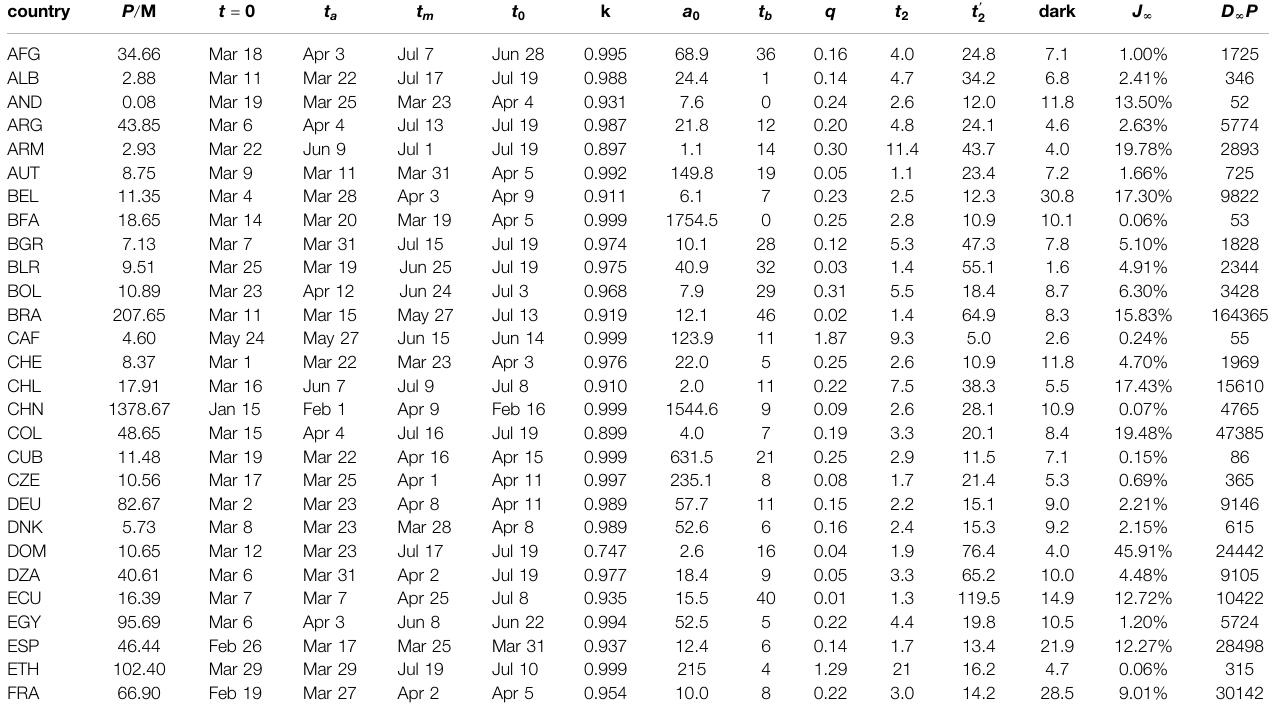
TABLE 2 | Model parameters and model implications. The columns are as follows: country ( α 3 code), population P in millions (M), outbreak time de fi ning t (cid:2) 0, fi tted time t a , estimated time t 0 corresponding to the reduced peak time τ 0 of j ( τ ) , fi tted SIR parameter k , fi tted initial infection rate a 0 , fi tted parameter t b , fi tted quarantine factor q , estimated doubling time t 2 characterizing the early exponential increase, estimated decay half life t ′ 2 characterizing the late exponential decrease, estimated unreported number of infections per reported number, estimated fi nal fraction J ∞ of infected population, fi nal number of estimated fatalities D ∞ P (cid:2) J ∞ Pf . We use f (cid:2) 0 . 005 as the probability to decease from a Covid-19 infection (reported plus